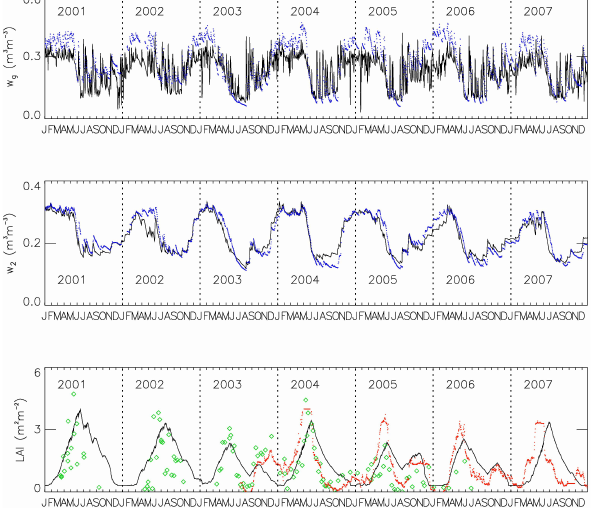
Fig. 7. Surface soil moisture ( w g ), root-zone soil moisture ( w 2 ), and Leaf Area Index (LAI) of the SMOSREX grassland for a seven year (2001–2007) period, simulated by ISBA-A-gs (black solid lines) and observed (blue dots for soil moisture, green diamonds for LAI estimates derived from destructive measurements, red dots for LAI estimates derived from surface reflectance